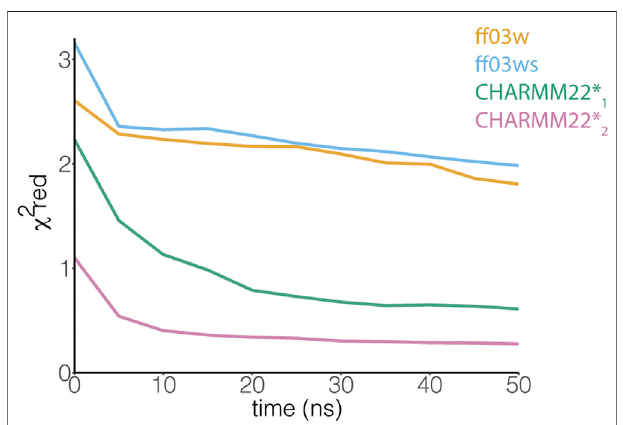
FIGURE3| TheensembleofAT-3 306-361 fromtheCHARMM22* 2 REMD simulation better resembles the experimental chemical shifts. The plot shows the comparison between experimental C α chemical shifts and calculated C α chemical shifts from the REMD simulations. Similar results have been achieved using the other backbone (N, HN, C, O, H α ) and C β chemical shifts. Among the protein force fi elds and water models tested in this study, the CHARMM22* 2 REMD simulation shows a better agreement with the experimental NMR